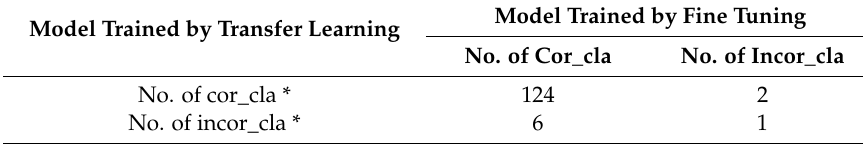
Table 7. Contingency table of the models trained by fine tuning and transfer learning. Model Trained by Fine Model Trained by Transfer Learning